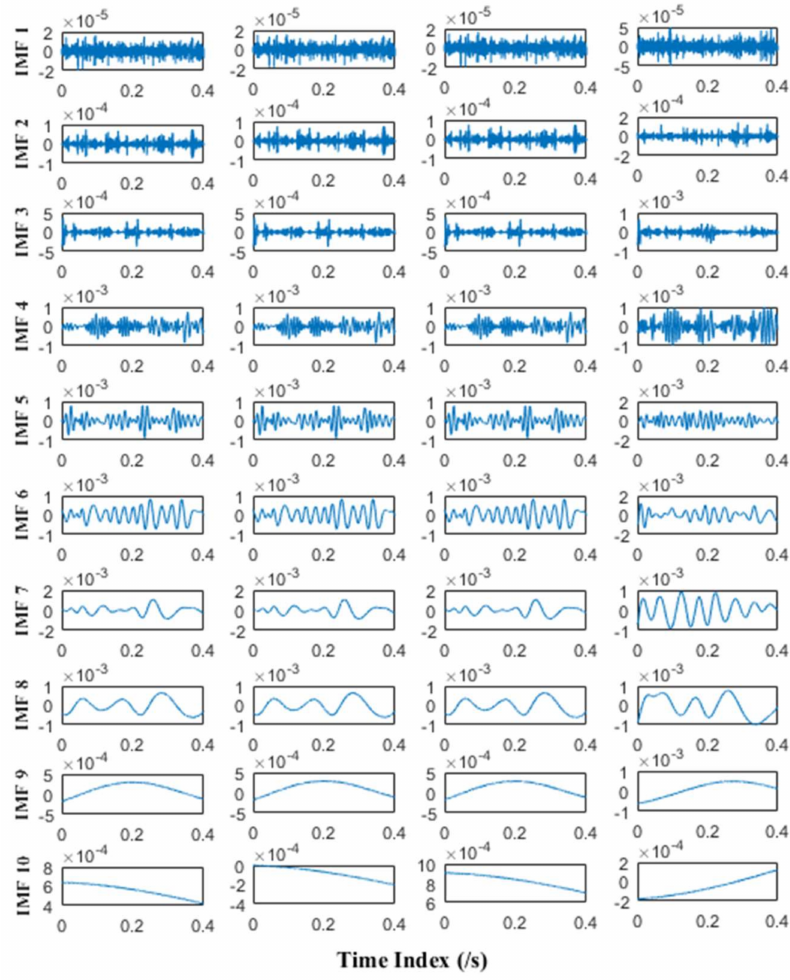
Figure 18. Time domain plots of IMFs of APIT-MEMD.